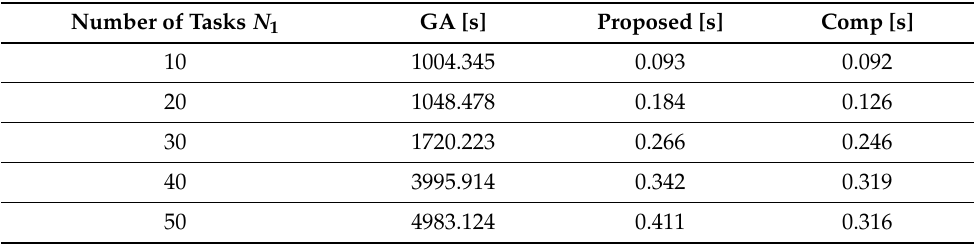
Table 2. Calculation time of each method in the case of τ = 0.2 and λ = 2.0. Number of Tasks N